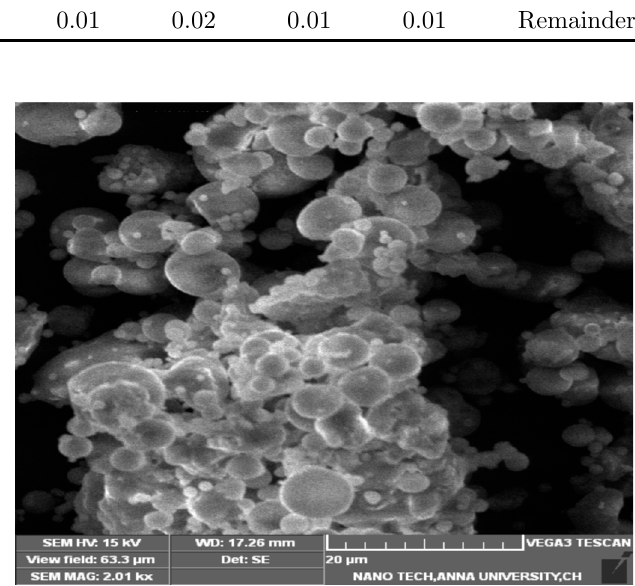
Table 1. Elemental constituents of LM6 alloy. Constituents